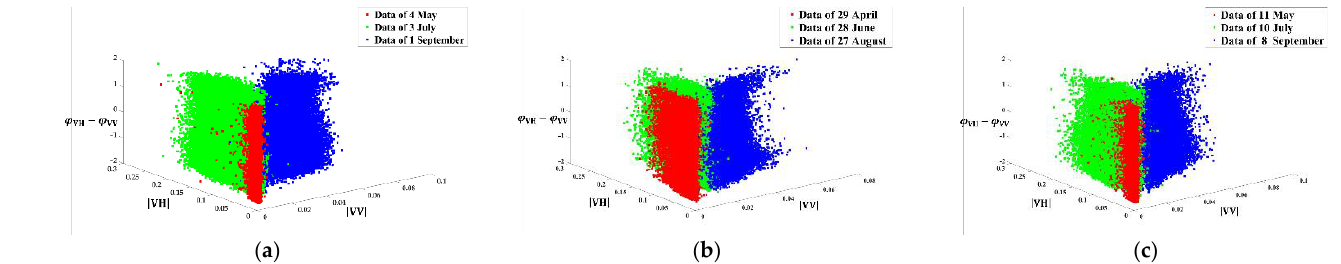
Figure 6. Scatter plots of the scattering traits of rice in different seasons of different years, where the three axes represent the amplitudes of the VH and VV polarization and the phase difference between VH and VV, respectively. ( a ) Scatter plots of the data from 2020. ( b ) Scatter plots of the data from 2021, which are temporally close to the data from 2020. ( c ) Scatter plots of the data from 2021 matched by the similar image pair matching